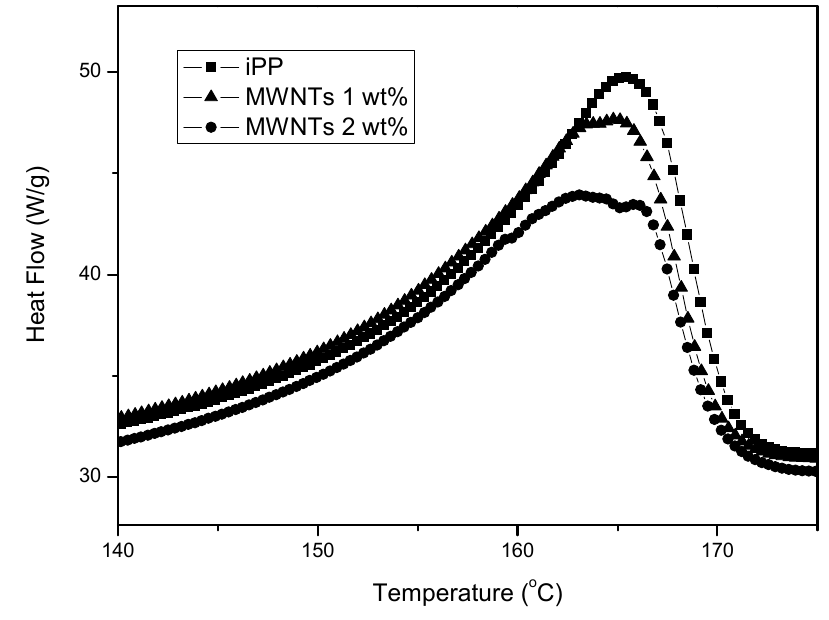
Figure 25. DSC thermographs for different weight percentages of nanotube loadings in